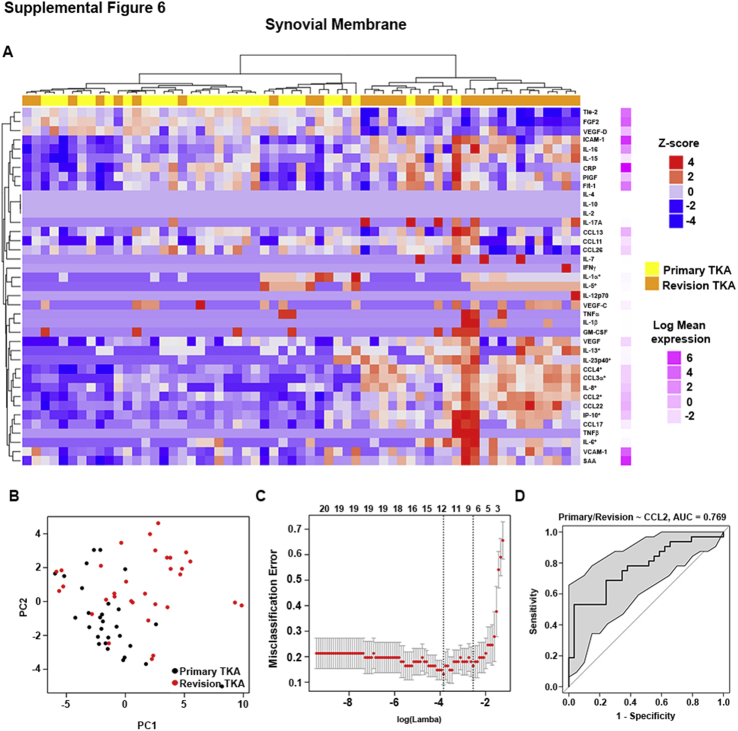
The inflammatory signature in synovial membrane does not effectively stratify patients into those undergoing revision total knee arthroplasty (TKA) from those undergoing primary TKA. A: Heat map of log-transformed protein intensity in synovial membrane isolated from patients undergoing primary or revision TKA clustered using the differentially expressed markers with the highest fold change. Asterisks indicate markers that were used for clustering analysis/stratification. B: Principal component analysis plot of all patients using all markers. C: Classification error as function of the number of markers included, cross validated using glmnet package. Dotted lines mark two important values of the regularization parameter λ, which controls the number of markers included. On the left is the value of λ that gives the minimum mean cross-validated error. On the right is the value that gives the most regularized model, such that error is within one SEM of the minimum. D: Receiver operating characteristic curve for classification with CCL2 alone [area under the curve (AUC), 0.769; 95% CI, 0.65–0.89]. CRP, C-reactive protein; FGF, fibroblast growth factor; Flt, Fms-like tyrosine kinase 1; GM-CSF, granulocyte-macrophage colony-stimulating factor; ICAM, intercellular adhesion molecule; IFN, interferon; IP, interferon gamma-induced protein 10; PIGF, placental growth factor; SAA, serum amyloid A; Tie, tyrosine kinase; TNF, tumor necrosis factor; VCAM, vascular cell adhesion molecule; VEGF, vascular endothelial growth factor.